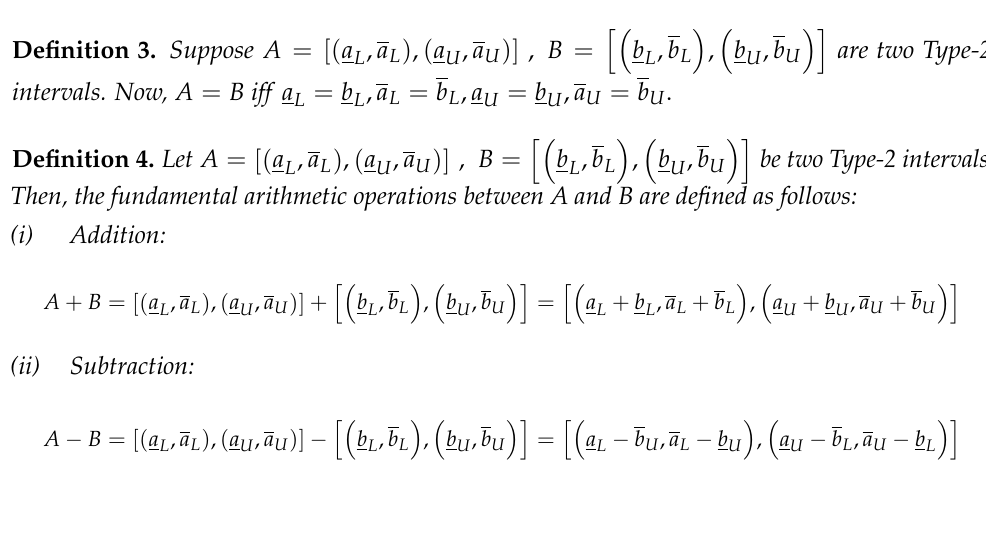
Figure 1. Graphical representation of Type-2 and Type-1 intervals.